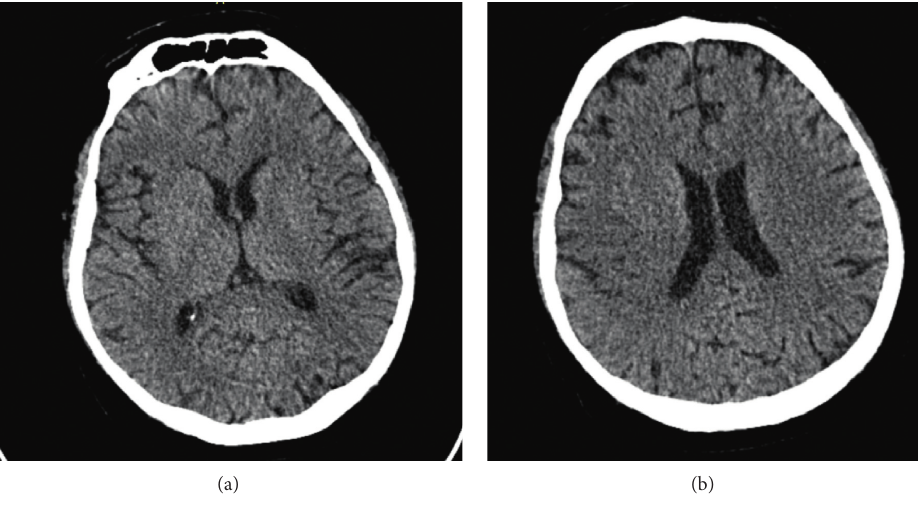
Figure 1: Plain CT brain: normal.